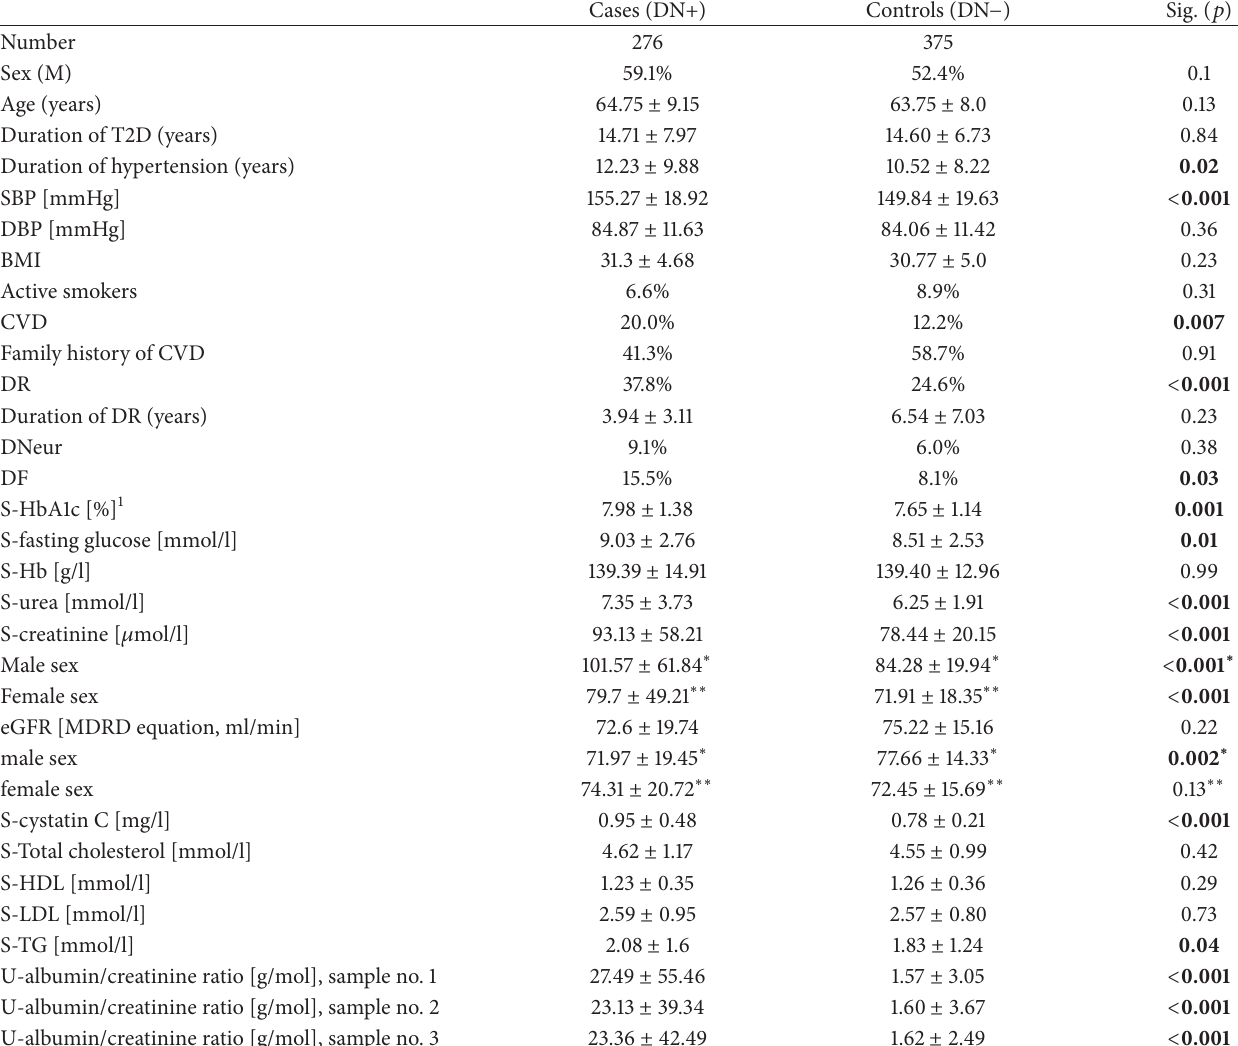
Table 1: Clinical and laboratory characteristics of cases and